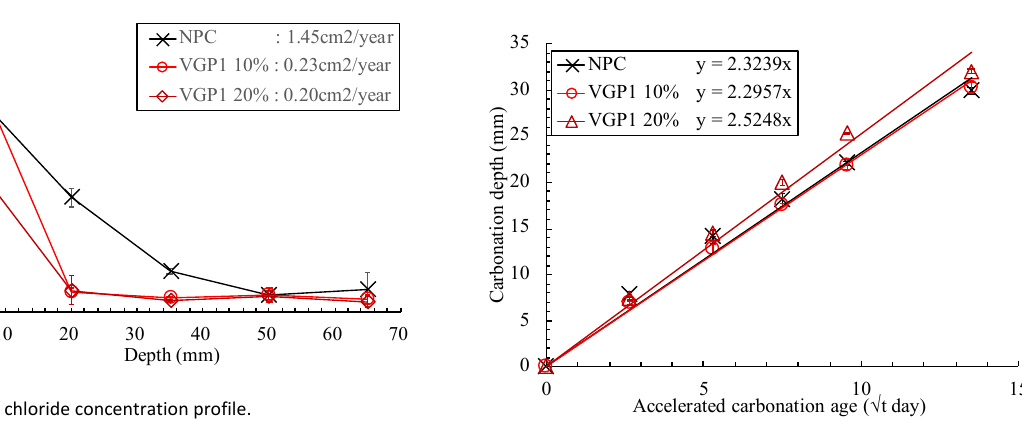
Figure 18. Total chloride concentration profile.